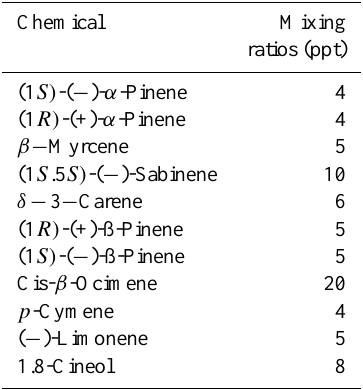
Table 2. Detection limits of monoterpenes sampled from glass sam- pling chamber using DVB-PDMS fibre coating and gas standard bottle.